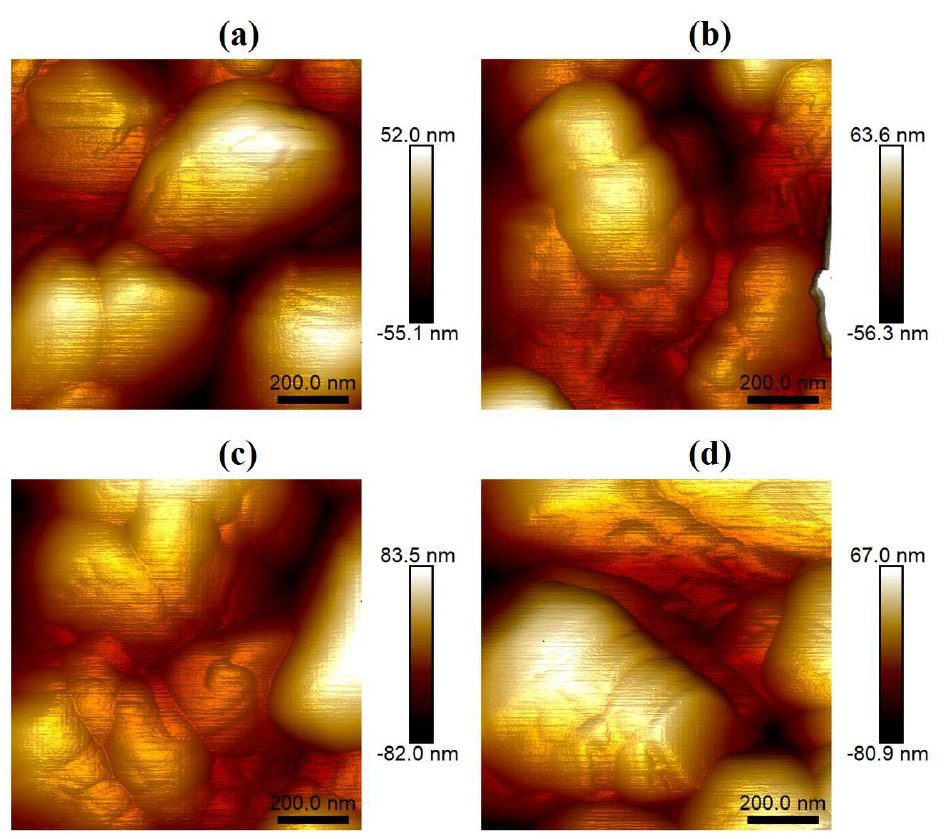
Figure 2. AFM images at L of 1 µ m of the surfaces of a silver thin film, which was prepared by using magnetron sputtering deposition.The denotations ( a – d ) represented four different positions randomly selected on these surfaces,